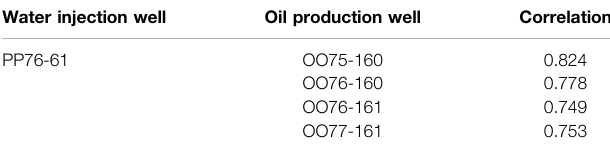
TABLE 2 | Correlations between water injection well PP76-61 and oil wells.